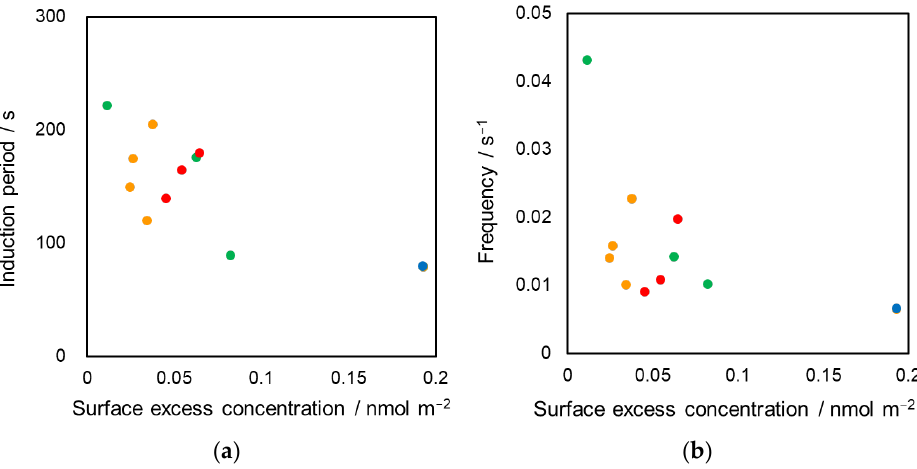
Figure 4. Relation between surface excess, DEHPA concentration on the oil-water interface, and the oscillation characteristics; ( a ) induction period and ( b ) frequency; Each symbol indicates the additive in aqueous phase. ●: no additive, ●: ethanol, ●: methanol, ●: acetone. Each plot was based on duplicate experiments.